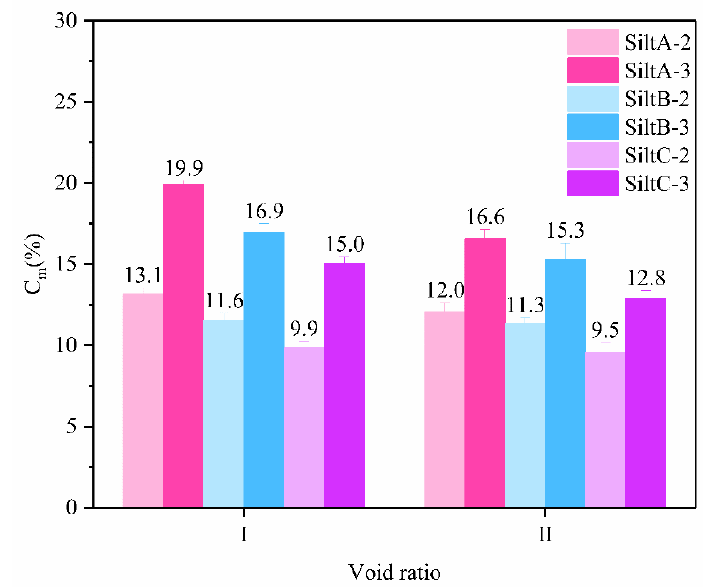
Figure 4. Effect of different pore ratio on calcium carbonate production.